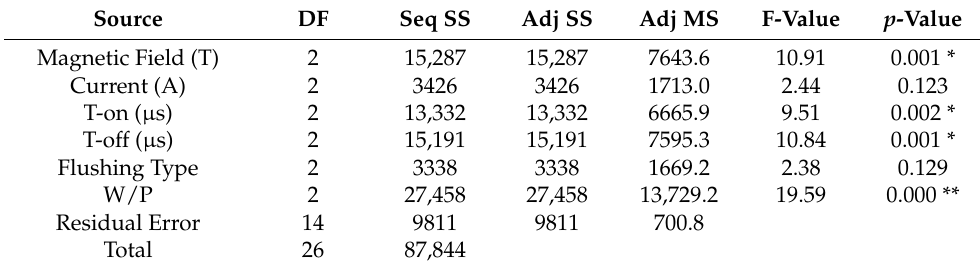
Table 5. ANalysisof VAriance (ANOVA) for Micro-Hardness (MH).